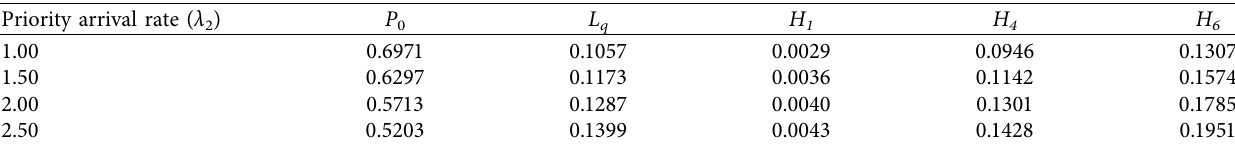
; ] , λ , ] , ] , θ 1 , α 0 . 4 , ] 7 4 . 2 (cid:31) 1 4 (cid:31) 4 1 (cid:31) 3 6 (cid:31) 2 (cid:31) (cid:31) (cid:31)